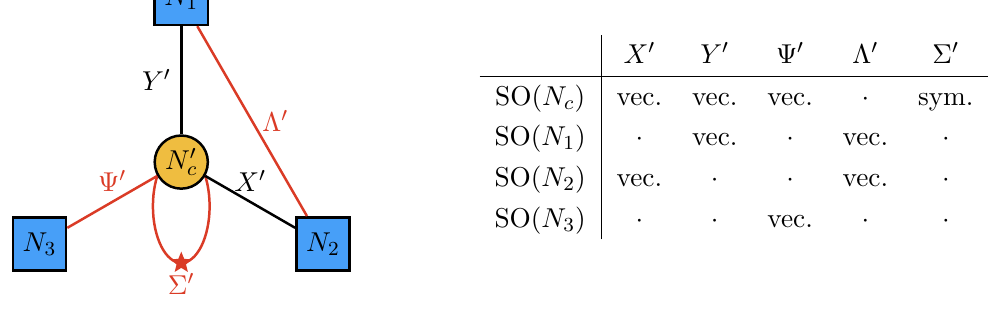
is given in eq. c